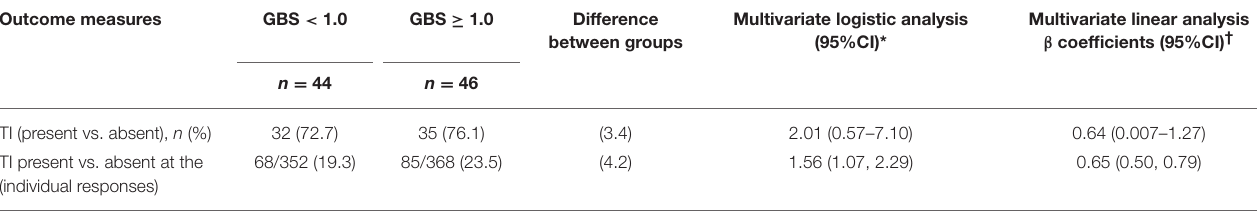
TABLE 2 | Multivariate analysis for the primary outcome.